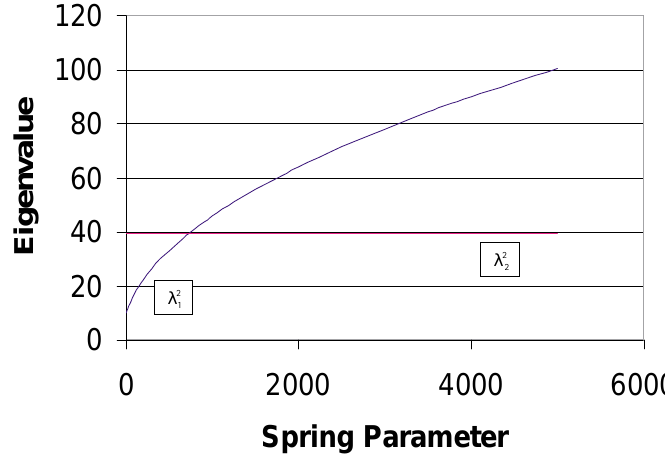
Fig. 5. Eigenvalue of simply supported beam with intermediate spring support (sine functions, α = 0 . 5 ).